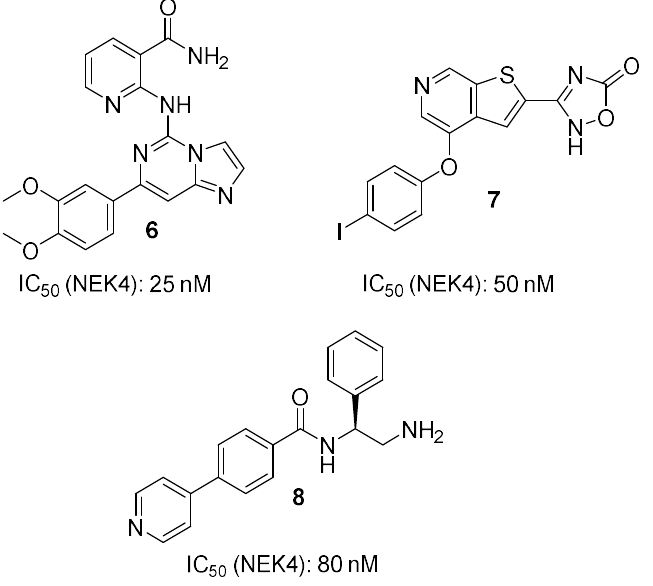
Figure 3. Non-selective NEK4 inhibitors reported in the literature so far.